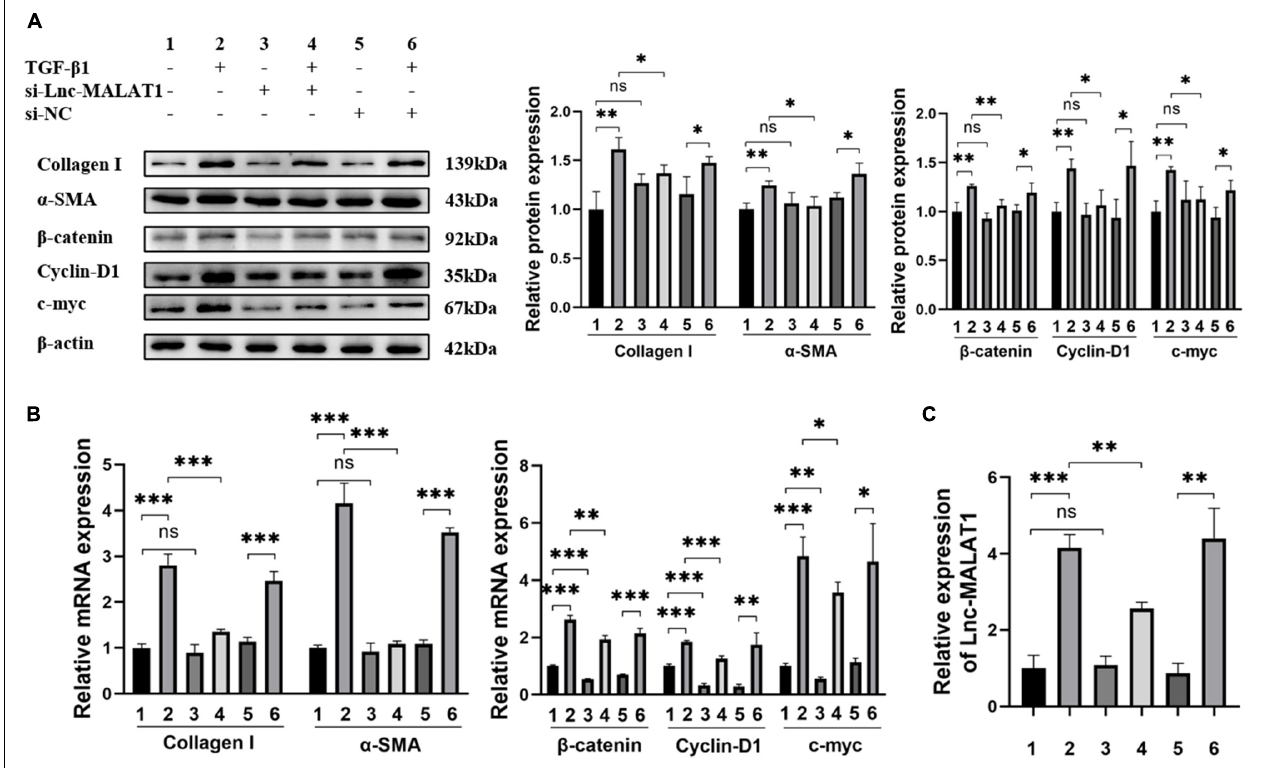
FIGURE 4 | Inhibition of TGF- β 1-induced fibrogenesis and β -catenin signaling in LX-2 cells by Lnc-MALAT1 knock-down. LX-2 cells were transfected with Lnc-MALAT1-specific siRNA or irrelevant small RNA, then treated with PBS or 10ng/ml TGF- β 1 and continued to culture for another 44 h. (A) Western blot analysis of collagen I, α -SMA, β -Catenin, Cyclin-D1, and c-myc. The numbers indicate different treatment. Relative intensity of the bands was expressed in the middle and right panels ( n = 6). (B) qRT-PCR analysis of the mRNA expression of collagen I, α -SMA, β -Catenin, Cyclin-D1 and c-myc ( n = 6). (C) qRT-PCR analysis of the expression of Lnc-MALAT1 ( n = 6). ∗ , ∗∗ , and ∗∗∗ represent p- values less than 0.05, 0.01 and 0.001,